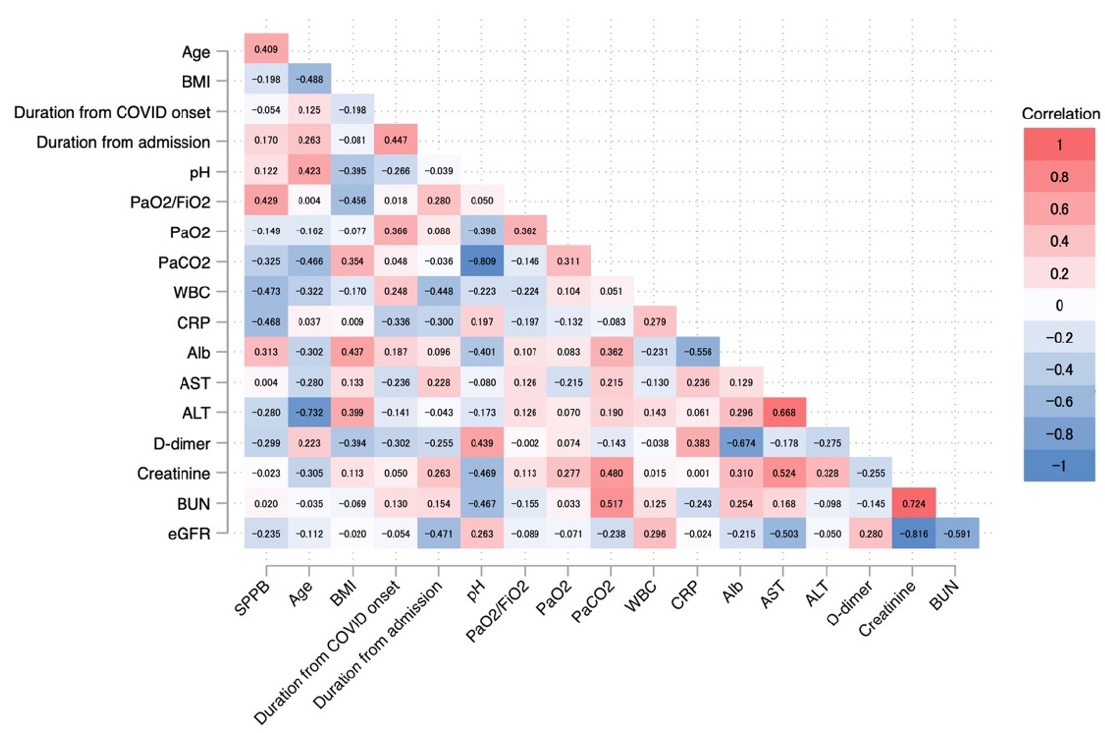
Figure 4. Spearman’s correlations between SPPB and other factors depicted in the heatmap.